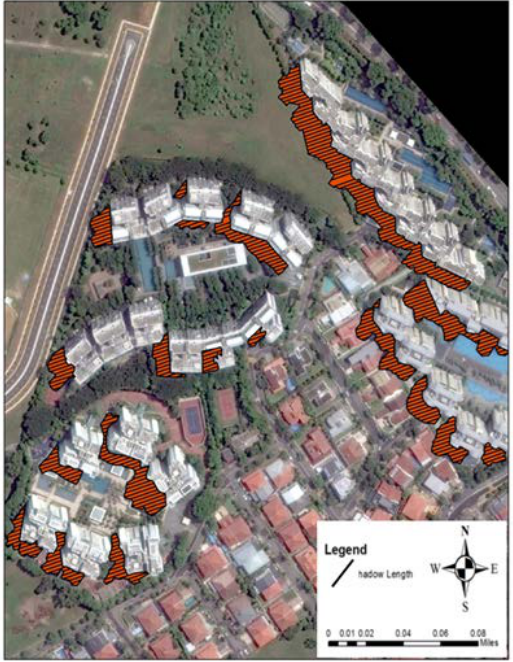
Figure 6. Illustration of shadow length calculation